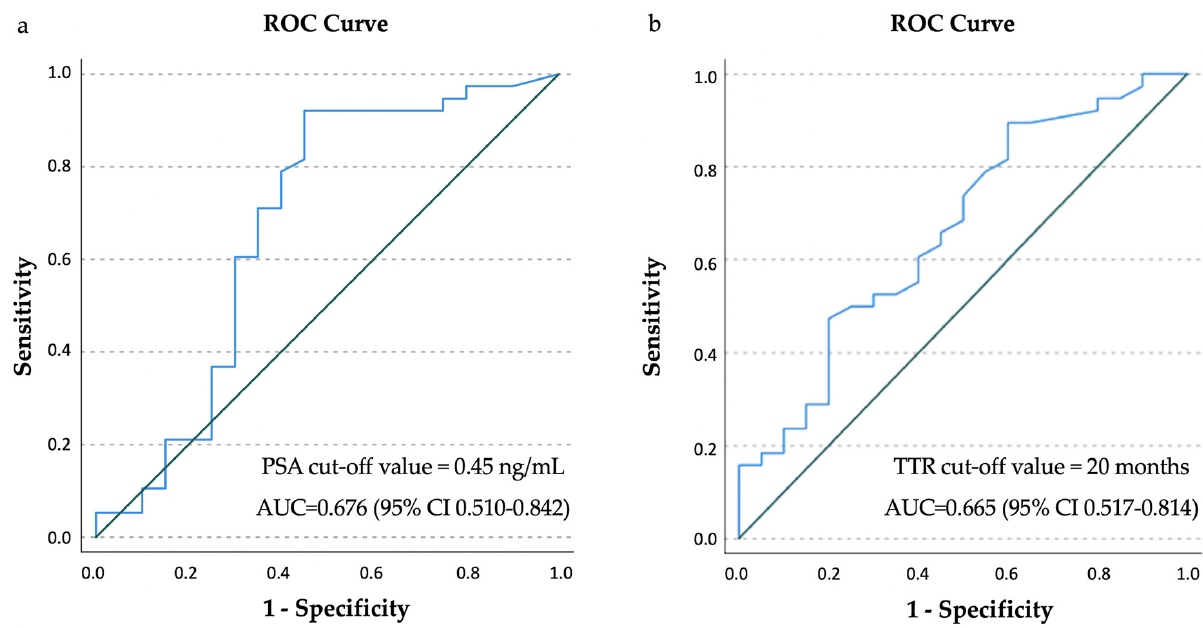
Figure 3. ROC analysis: ( a ) the PSA optimal cut-off value was 0.45 ng/mL with an AUC of 0.676 and ( b ) time from primary treatment to PSA relapse (TTR) optimal cut-off value was 20 months with an AUC of 0.665.